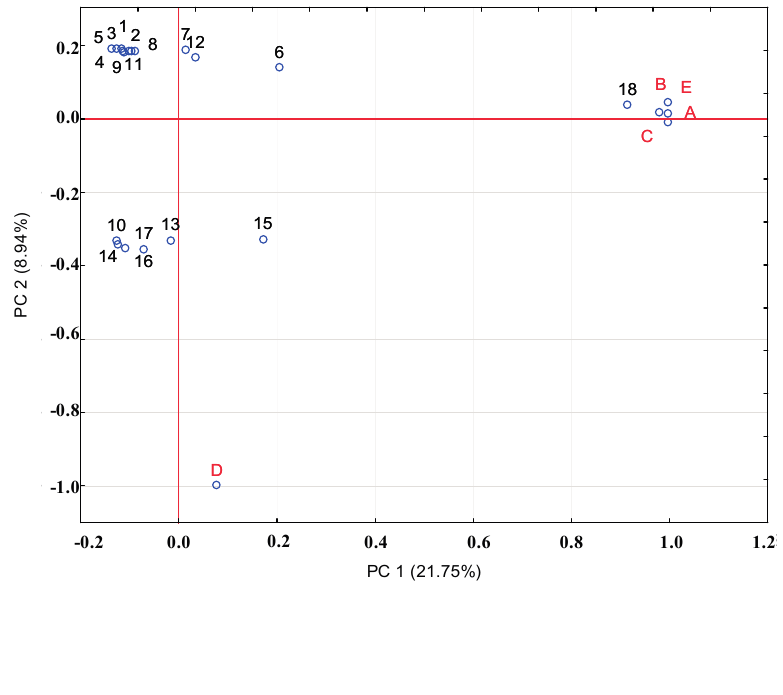
Figure 3. Loading plot for principal component analysis (PCA) of the first two factors. ( A ) white horse chestnut no infected leaves (June); ( B ) white horse chestnut infected leaves (June); ( C ) white horse chestnut infected leaves (September); ( D ) red horse chestnut no infected leaves (September); E- red horse chestnut infected leaves